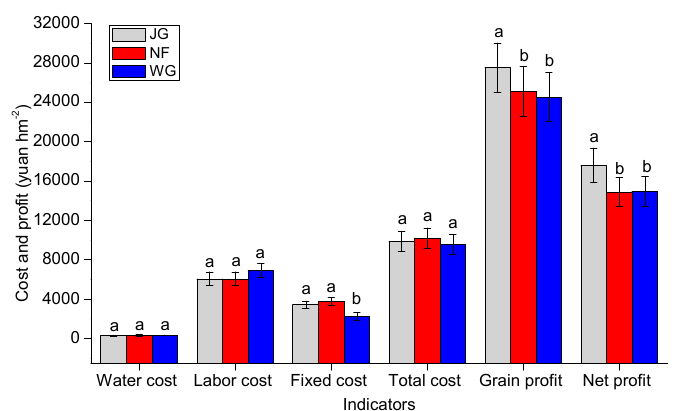
Figure 8. Cost and profit of maize under various mulching planting patterns. Note: JG represents straw mulching; NF represents organic fertilizer mulching; WG represents no mulching. The average local price for maize was 1.70 yuan kg − 1 . The total cost included the cost of seed, fertilizers, sows, micro-spray irrigation belts, water pipes, maize straw, organic fertilizers during the trial. Labor costs included the layout of the sample plot, weeding, sampling, irrigation, spreading fertilizer, and determination of sample. Bars labeled with different letters (lowercase) differed remarkably among different indexes ( p <0.05).